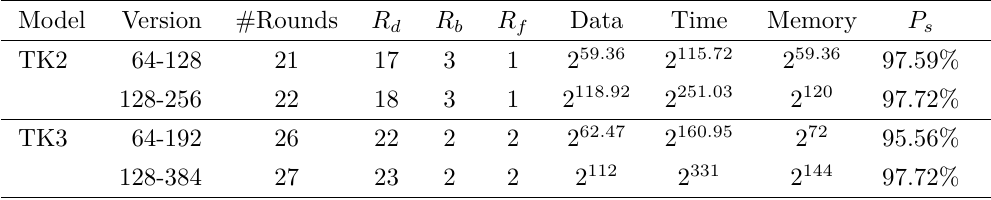
Table 8: Results of related-tweakey rectangle attacks on SKINNY- n -2 n and SKINNY- n -3 n